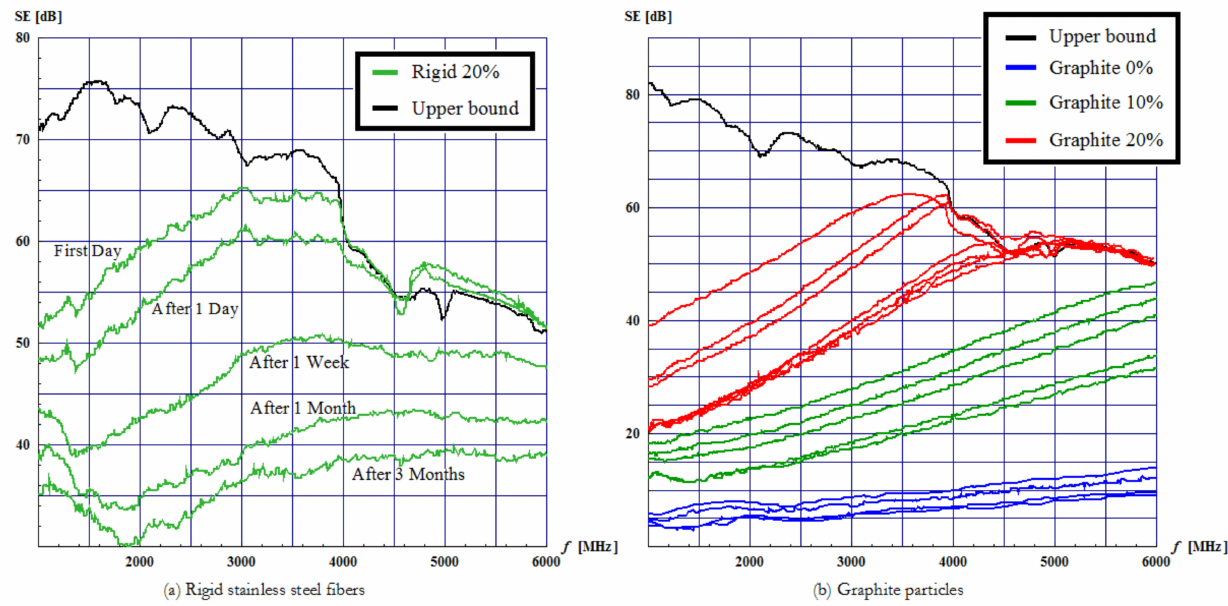
Figure 8. Shielding effectiveness versus wave frequency for tested elements: ( a ) material with steel fibers addition, ( b ) material with graphite addition (after